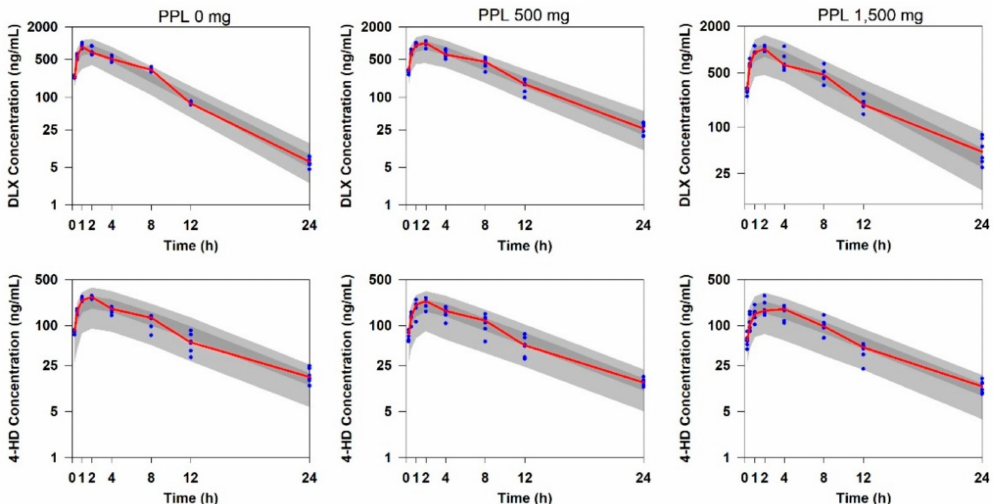
Figure 4. Visual predictive check plots for the final model for predictions of the PK profiles of (upper) DLX and (lower) 4-HD in rats. Open circles: observed concentrations, solid red line: median of the observed concentrations, dark grey area: 95% confidence interval (2.5 th –97.5 th percentiles) of the median predicted concentrations, and light grey area: 90% prediction intervals (5.0 th to 95.0 th percentiles) of the predicted concentrations.